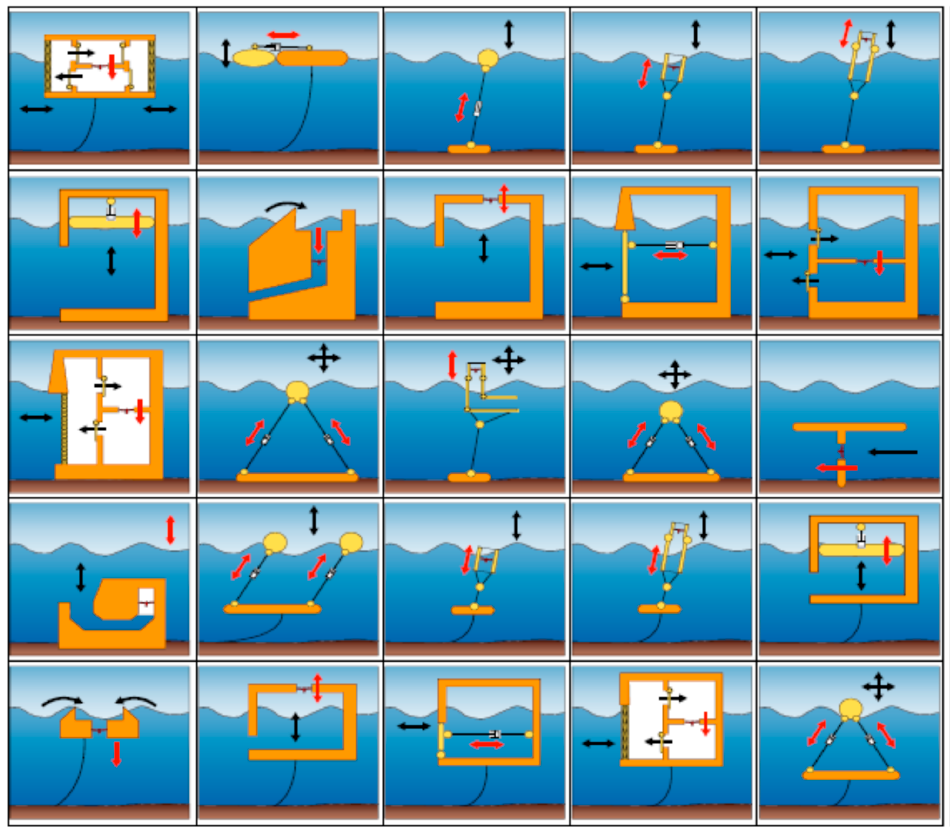
Figure 5. Different devices to extract energy from the waves [19].